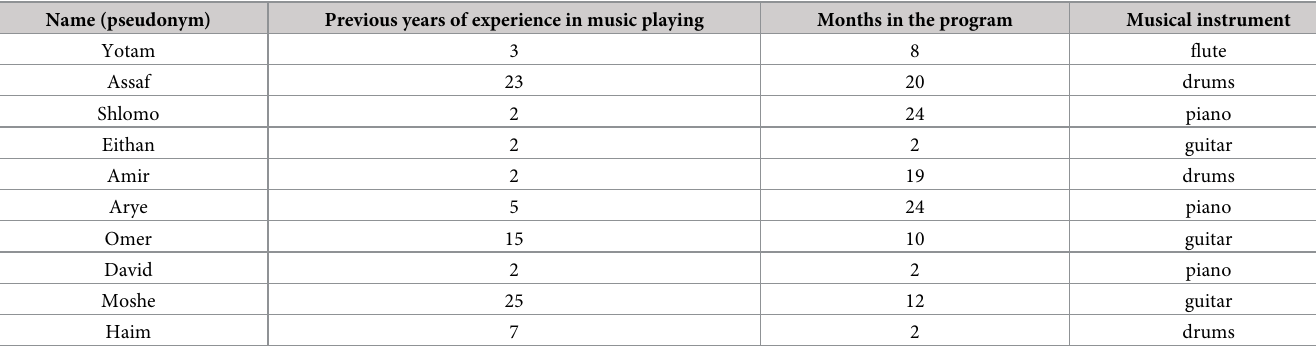
Table 1. Participants’